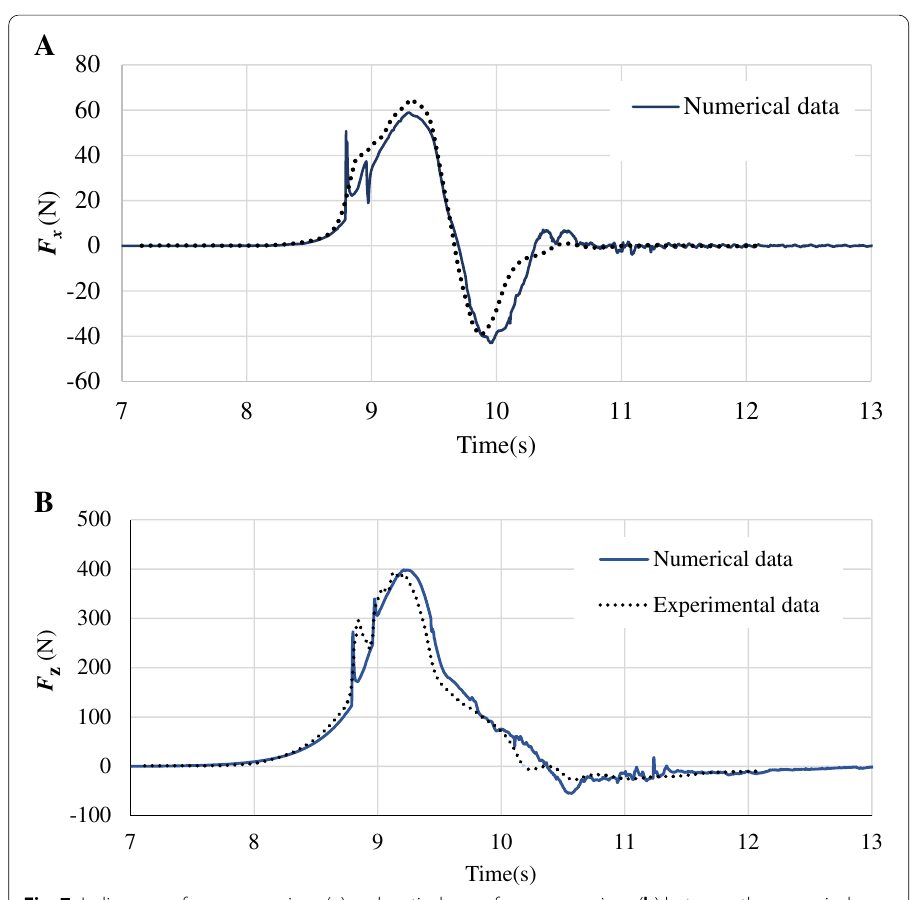
Fig. 7 In-line wave force comparison ( a ) and vertical wave force comparison ( b ) between the numerical method by this study and the experimental data measured by Huang et al.